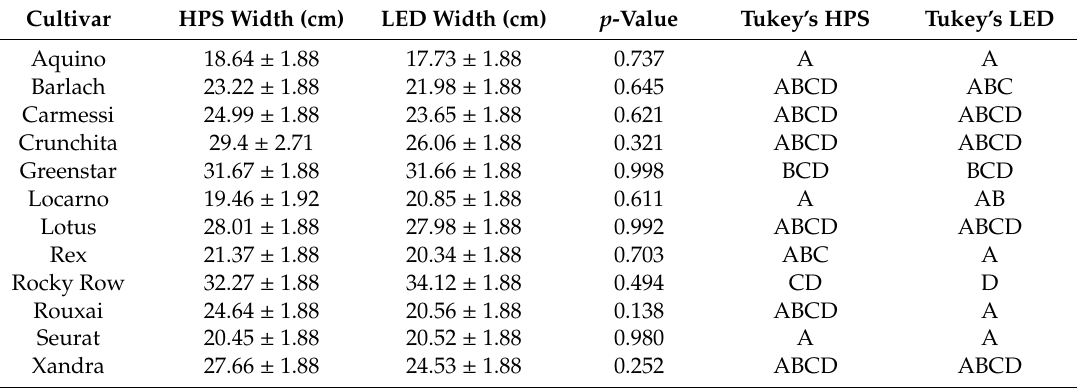
Table 8. Plant shoot diameter of 13 cultivars of lettuce in phase 1, in which plants were grown under standard error (SE) of circa 36 plants from three crop cycles. A t -test was used to compare HPS versus LED within a cultivar ( p -value) and Tukey’s Honestly Significant Di ff erence at α = 0.05 was used to compare cultivars with the HPS or LED treatment.